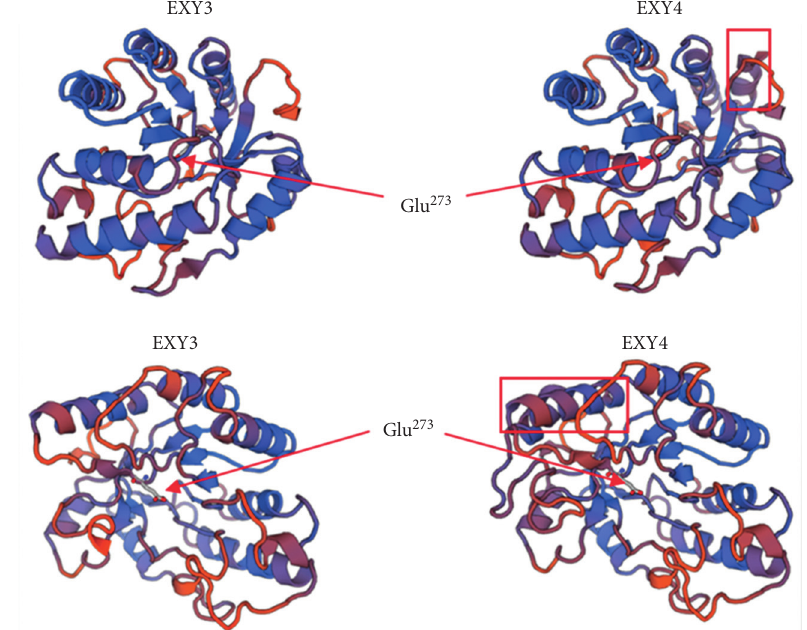
Figure 6: The three-dimensional structure models of the EXY3 and EXY4 proteins. The Glu273 is the putative catalytic site in both EXY3 and EXY4. Upper, one face, and lower, the opposite faces of EXY3 and EXY4, and the main difference between EXY3 and EXY4 are shown in the red